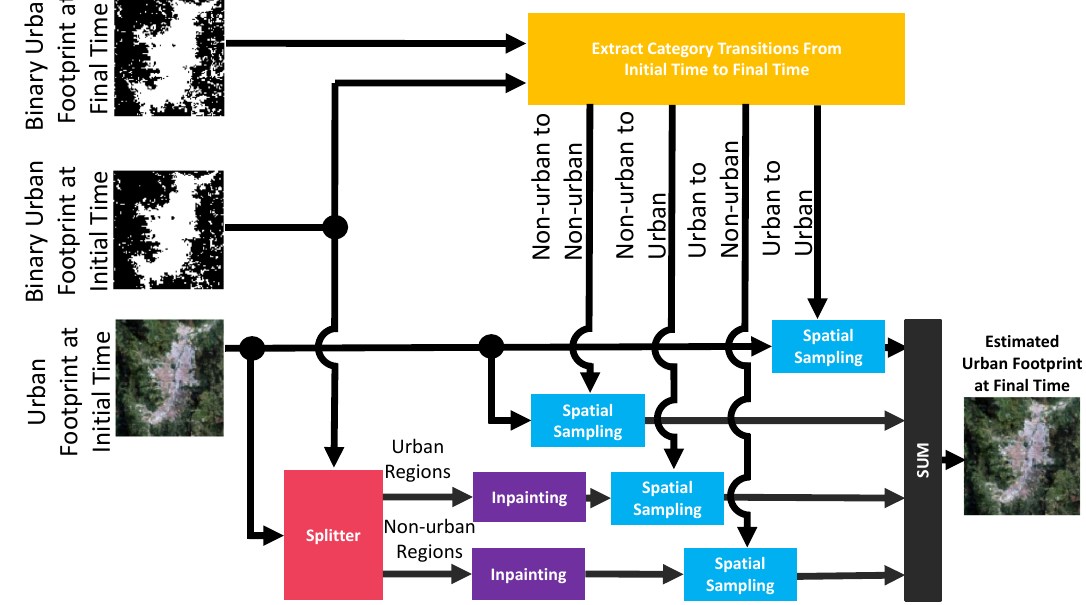
Figure 13. Semantic inpainting to estimate the urban footprint in color at a final time from the value at an initial time and the the binary urban footprints at the initial and final